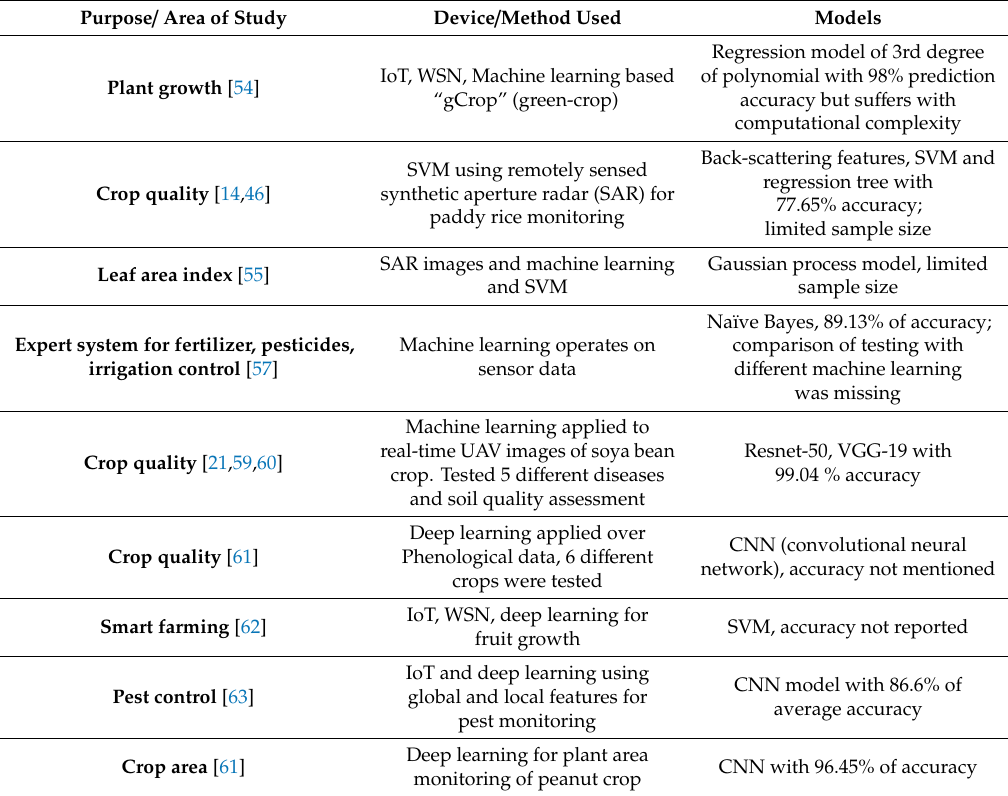
Table 2. Research on IoT based SEM